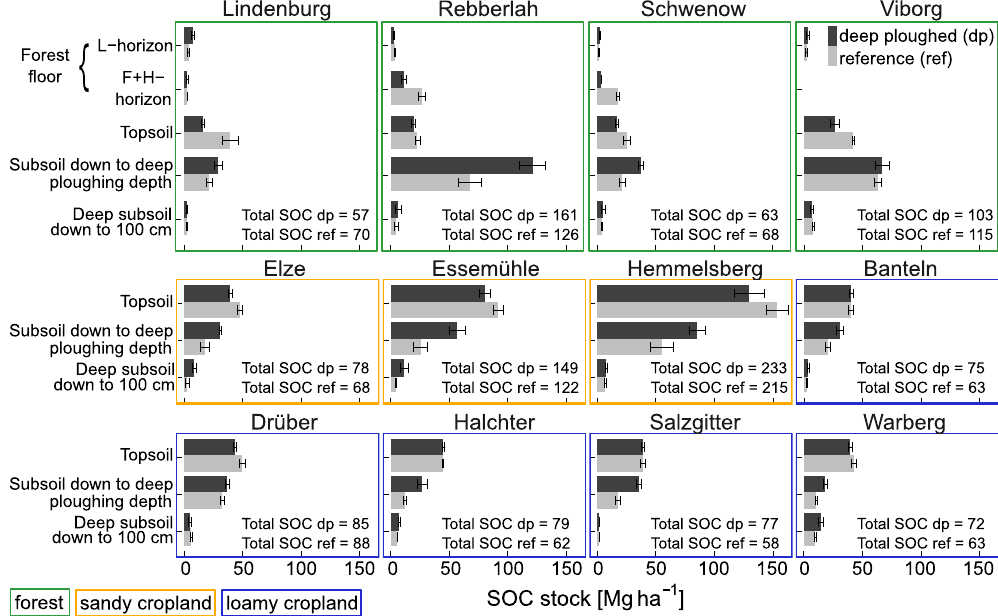
Figure 2. SOC stocks at different soil depth increments in deep-ploughed and reference plots. Bars represent average SOC stocks in soil cores (n = 5), whiskers show standard error. Subsoil and buried topsoil stripes were not sampled separately. Total SOC stock sums for forest sites include forest